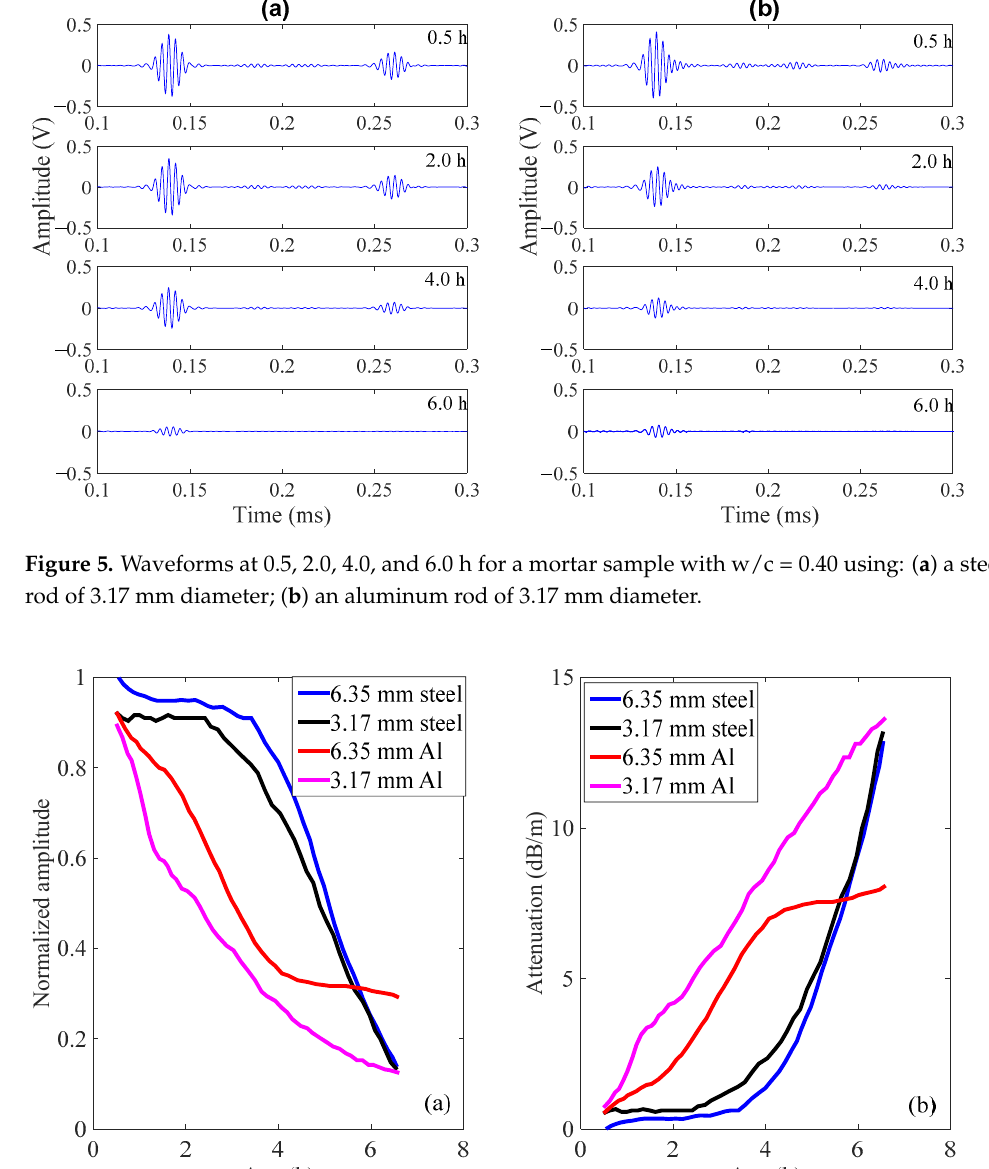
Figure 6. Four different rods in mortar sample with w/c = 0.40. ( a ) normalized wave amplitude and ( b ) attenuation.